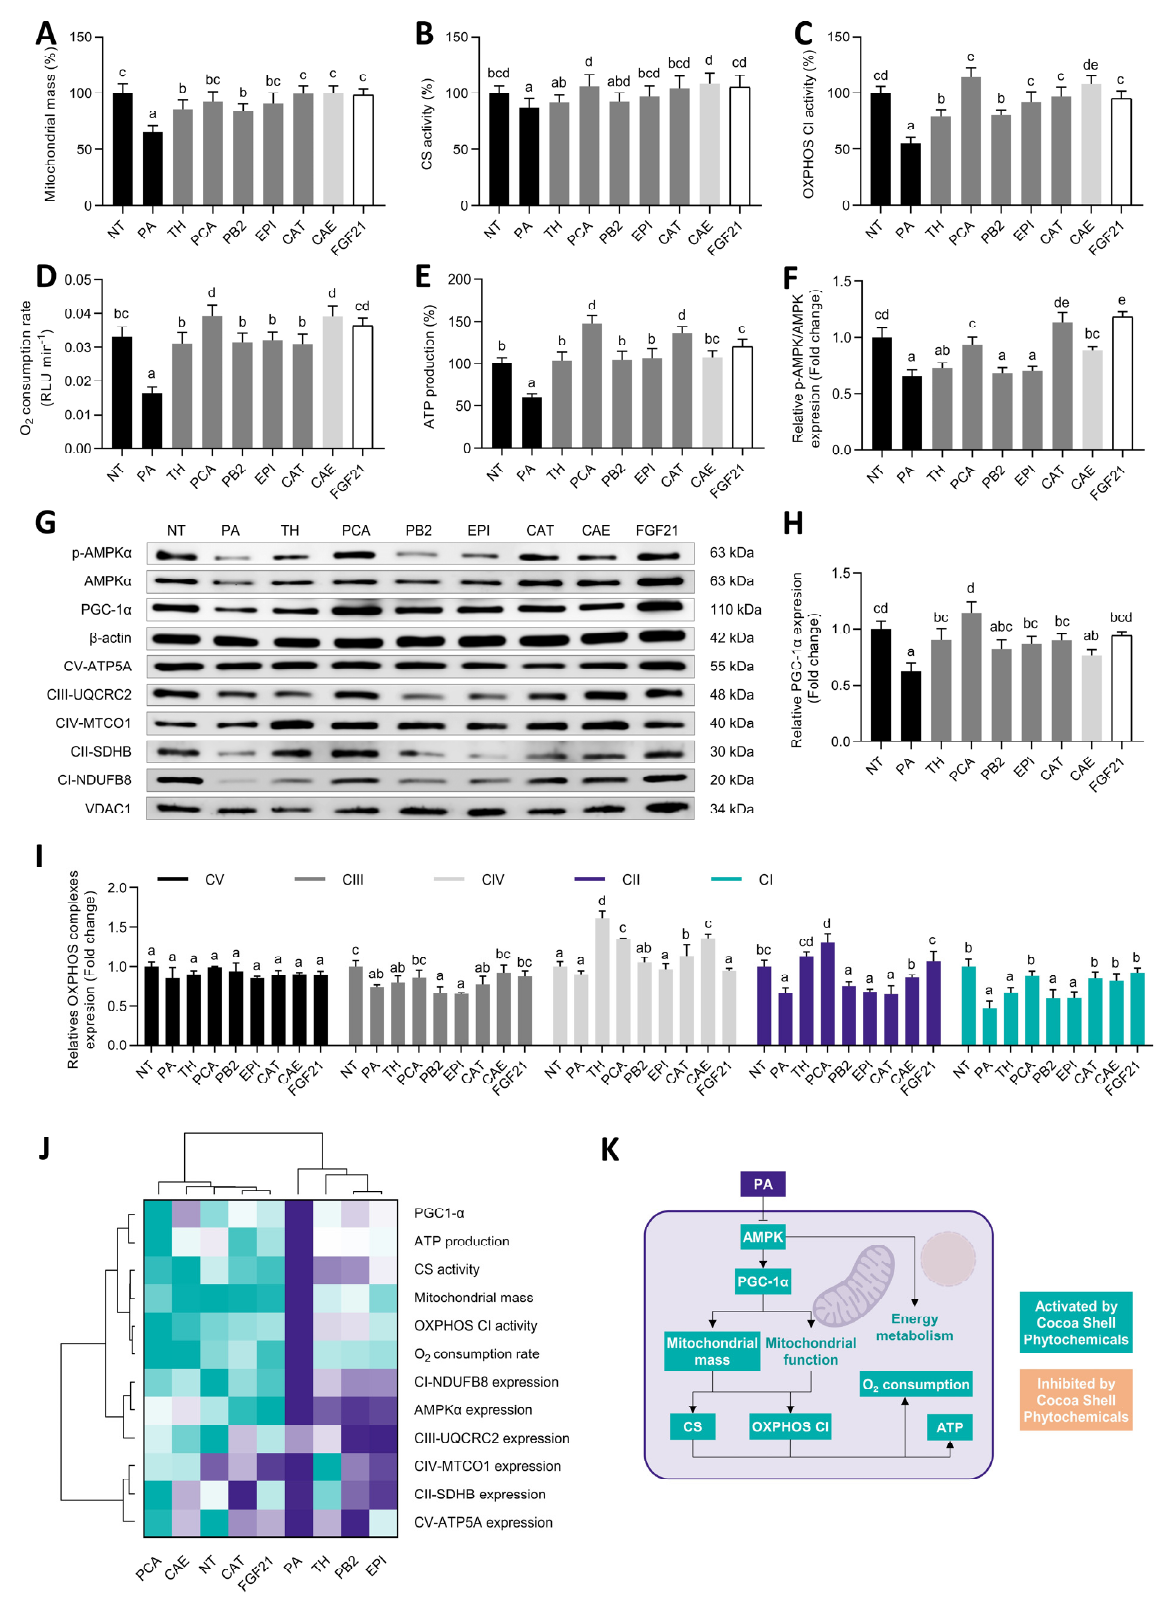
Figure 5. Regulative effects of pure phytochemicals from the cocoa shell (50 µmol L − 1 ), aqueous extract (CAE, 100 µg mL − 1 ), and FGF21 (20 nmol L − 1 ), in the presence of palmitic acid (500 µmol L − 1 ), on the mitochondrial function of HepG2 human hepatocytes. Cocoa shell phytochemicals attenu- ated the loss of mitochondrial mass ( A ) and mitochondrial function as measured by citrate synthase